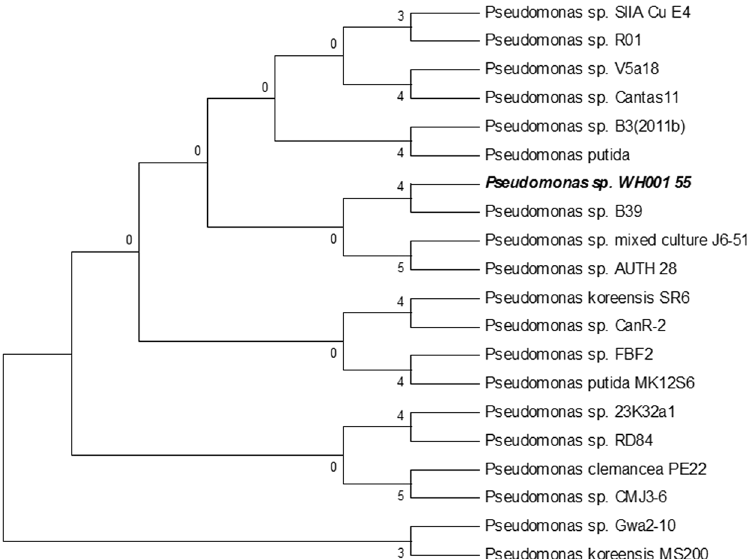
Figure 1. The evolutionary tree was inferred using the Minimum Evolution (ME) method. The bootstrap consensus tree inferred from 1000 replicates was taken to represent the evolutionary history of the taxa analyzed. The phylogenic tree was constructed using the ME algorithm in MEGA version 7.0. The isolate showed 97% similarity with members of the Pseudomonas